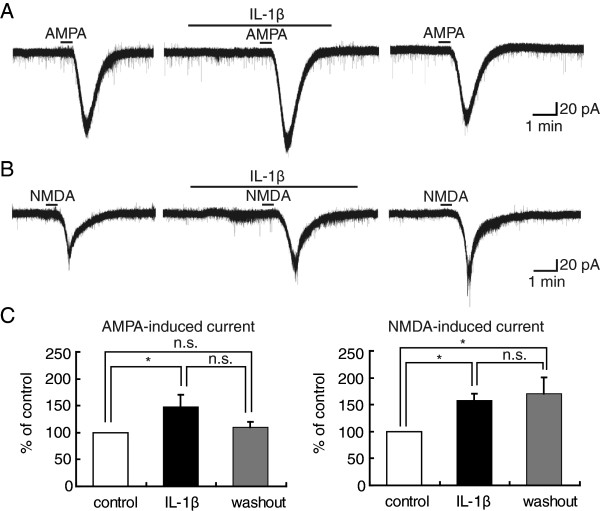
Enhancement by IL-1β of AMPA- and NMDA-induced currents in rat substantia gelatinosa (SG) neurons. (A) Recordings of AMPA-induced inward currents, which were enhanced in the presence of IL-1β and recovered at 30 min after its washout. Drug application is marked with bars. (B) Recordings of NMDA-induced inward currents, which were enhanced by IL-1β; this enhancement persisted at 30 min after its washout. (C) Bar graphs showing the averaged peak amplitude of AMPA (left, n = 12)- and NMDA (right, n = 7)-induced currents under the treatment with IL-1β (black bar) and after its washout (gray bar), relative to those before this treatment (control, open bar). In this and subsequent figures, vertical lines accompanied by bars indicate SEM; *: P < 0.05, compared with control; n.s.: not significant (t test). In this and subsequent figures, the concentrations of IL-1β used was 10 ng/ml; the concentrations of AMPA and NMDA used were 5 and 50 μM, respectively; the AMPA and NMDA responses were induced at holding potentials (HPs) of −70 and −50 mV, respectively.